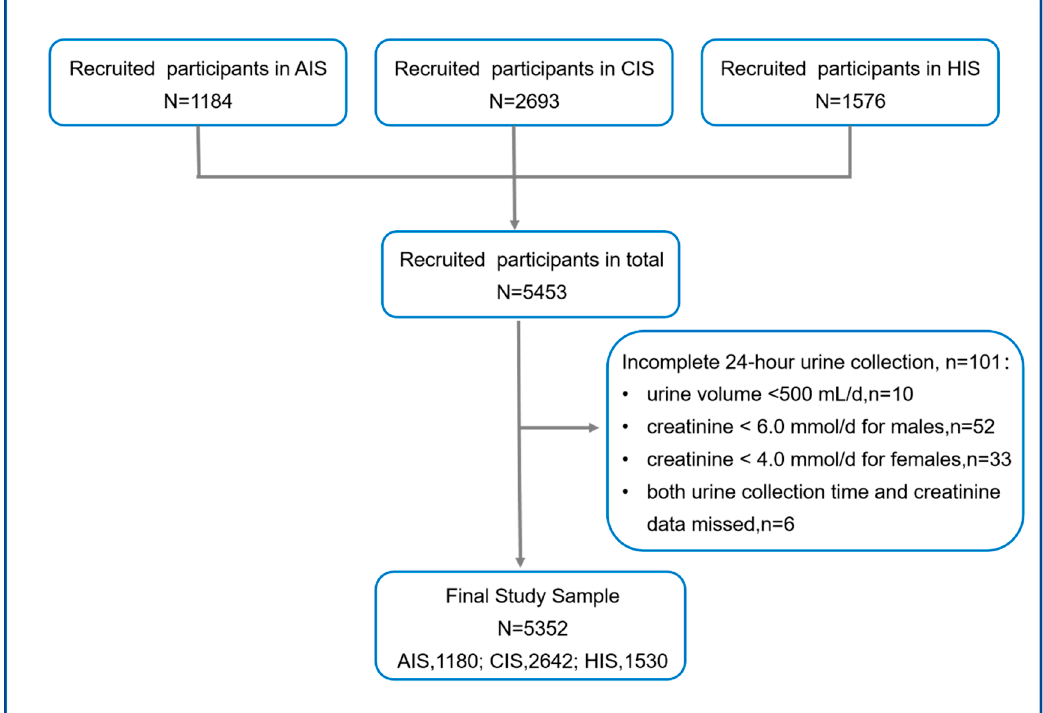
Figure 1. Flowchart of participants. We analyzed three independent RCTs for the Action on Salt China, including the AppSalt-based salt reduction program for primary school children and their families (AIS), the community-based comprehensive salt reduction intervention study (CIS), and the home cook salt reduction intervention study (HIS).